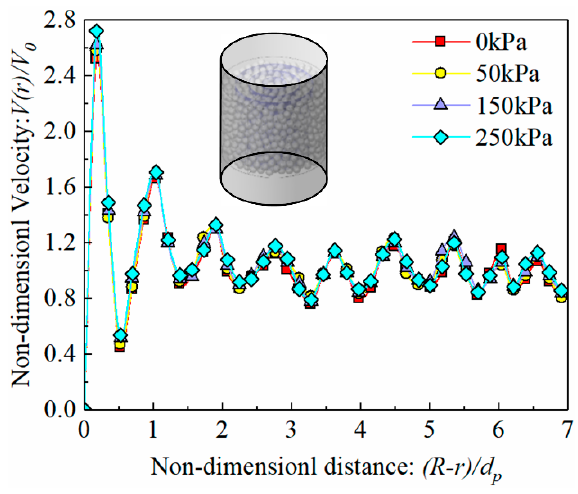
Figure 8. Radial mean dimensionless velocity under different vertical pressures.